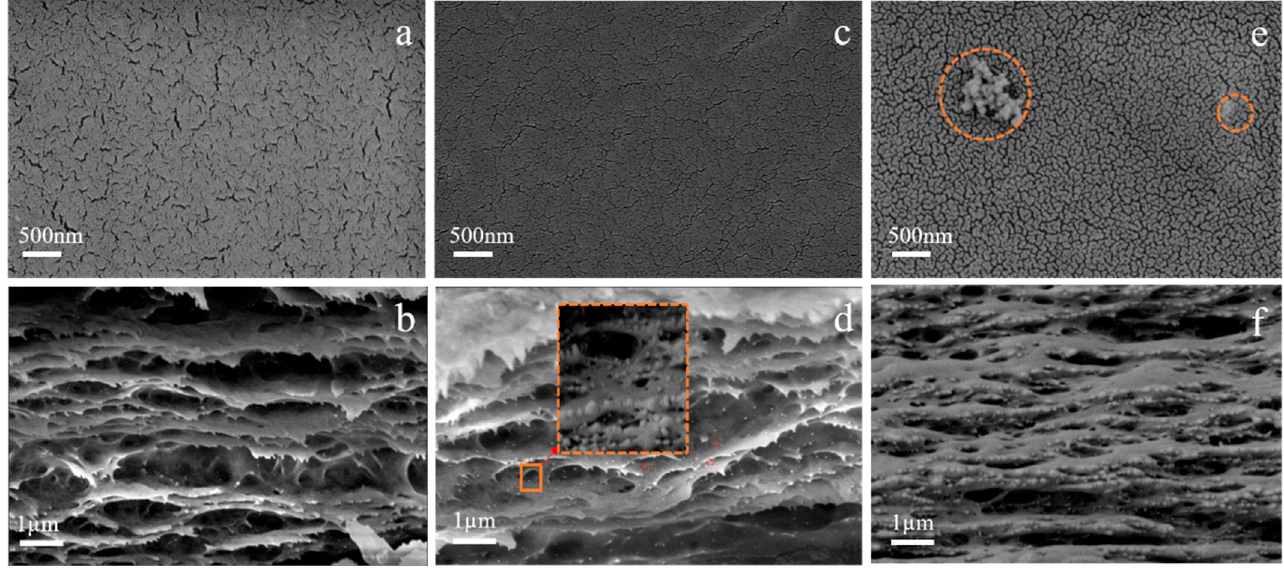
Figure 8. ( a , c , e ) SEM of the surface of BCM, 1 wt.% ZrO 2 /BCM and 2 wt.% ZrO 2 /BCM; ( b , d , f ) SEM of the cross section of BCM, 1 wt.% ZrO 2 /BCM and 2 wt.% ZrO 2 /BCM.